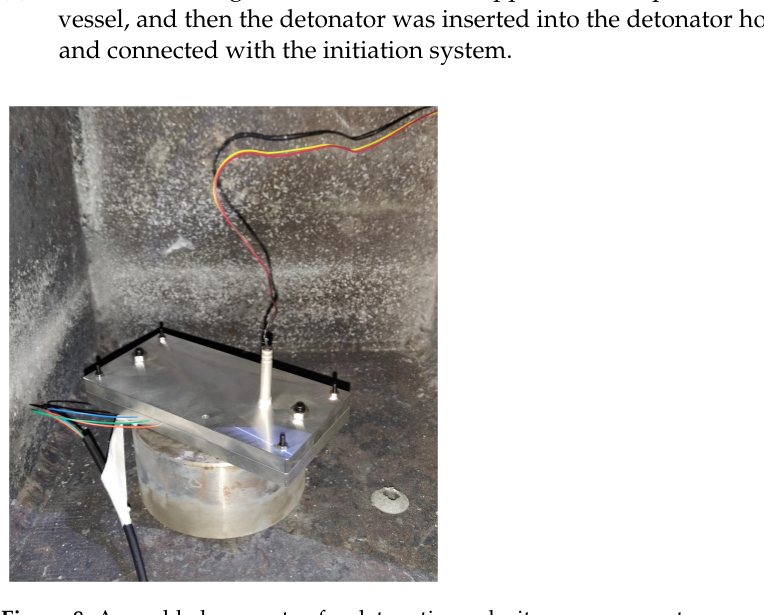
Figure 8. Assembled apparatus for detonation velocity measurement.